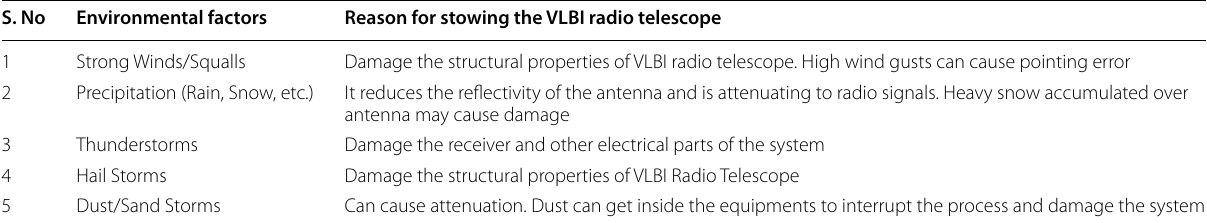
Table 2 Following table discusses the environmental factors and their effect on the operation pf